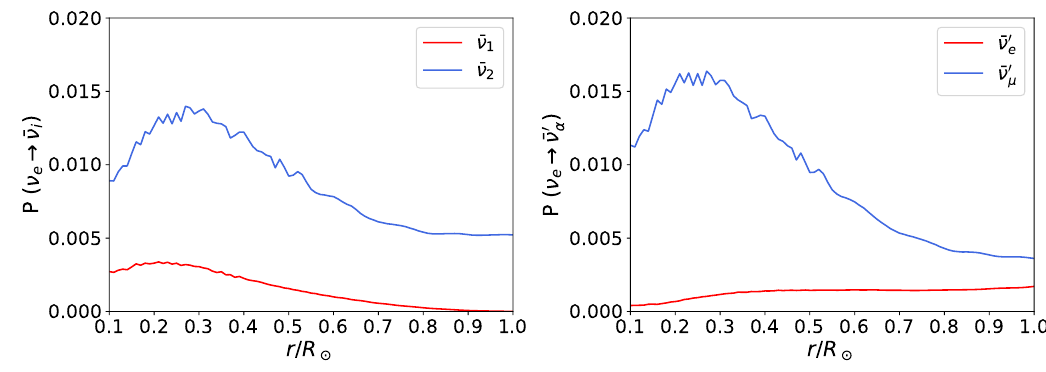
Figure 2 . Two-flavour antineutrino appearance probabilities for the mass eigenstates (left panel) and for the states in the primed basis (right panel) as functions of the distance to the centre of the Sun. Neutrino energy E = 10 MeV, transition magnetic moments µ 12 = 10 − 12 µ B , µ 13 = µ 23 = 0 and the ν e production coordinate r 0 = 0 . 05 R (cid:12) are